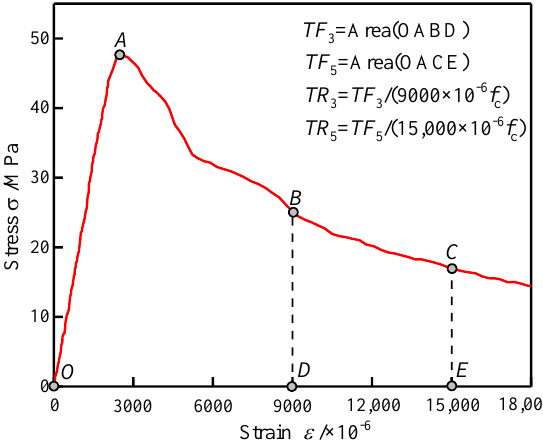
Figure 6. Definitions of toughness and specific toughness.